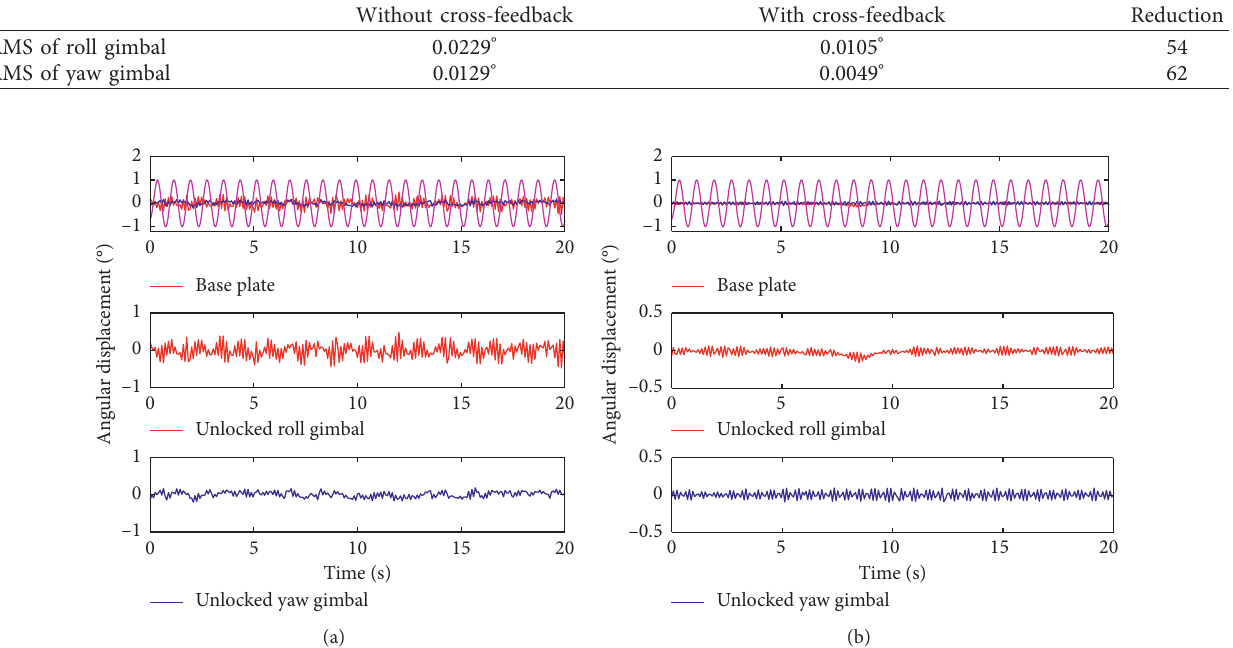
Figure 18: Angular displacements of roll and yaw gimbals with dynamic base plate: (a) without cross-feedback and (b) with cross-feedback.